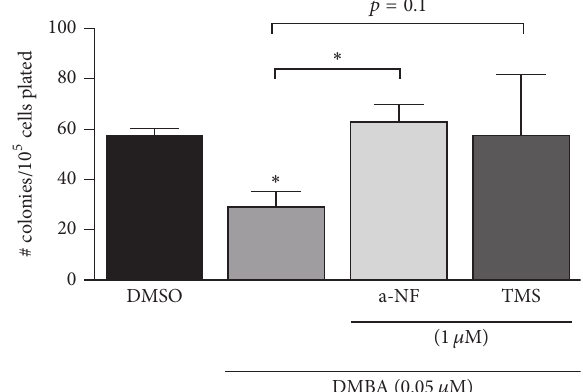
Figure 6: Reversal of DMBA suppression of PreB CFU activity from BMC by Cyp1b1 inhibitors, a-naphthoflavone (a-NF) and tetramethoxystilbene (TMS). To enhance sensitivity to DMBA, BMC from XPC − / − mice (low DNA repair) are used for the OP9 coculture.DMBAconcentrationisthendecreasedto0.05 𝜇 M,which ismoresensitivetoinhibitors.Inhibitors(1 𝜇 M)wereincubatedwith the cells for 24 hours prior to PreB CFU analyses. ∗ 𝑝 < 0.05 .